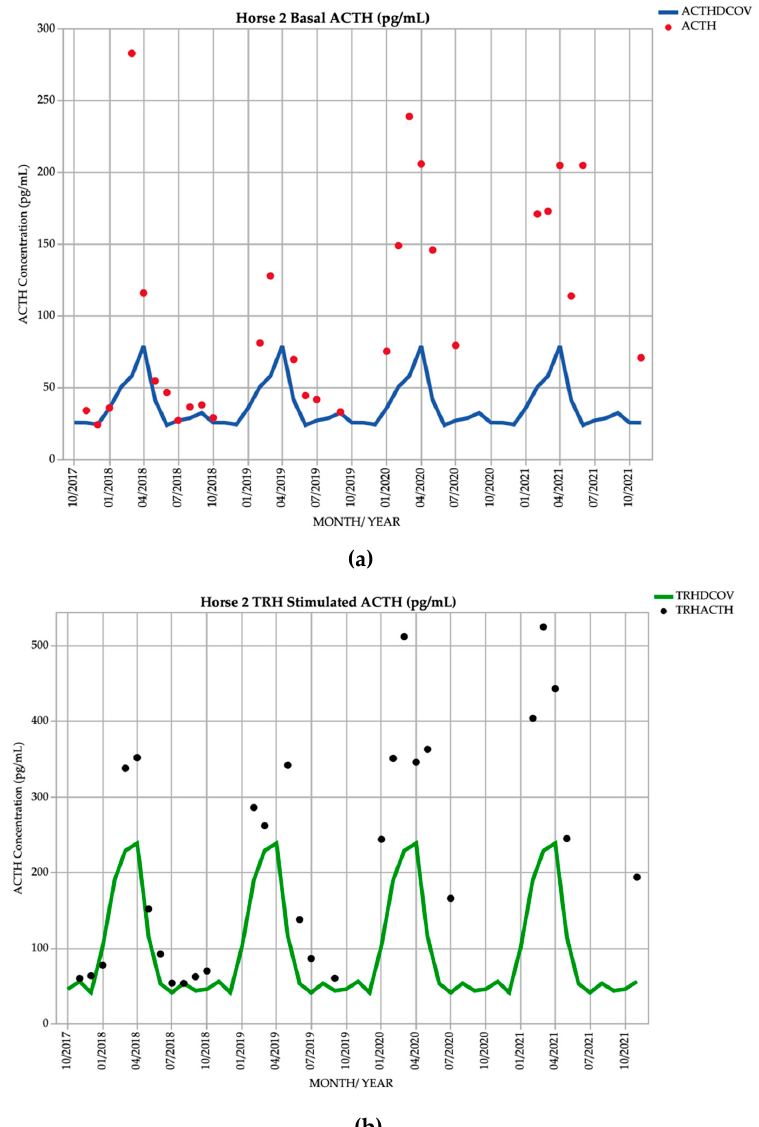
Figure 2. Monthly ACTH concentration (pg/mL) in Horse 2 (21 ‐ year ‐ old Warmblood mare), com ‐ pared to locally derived, seasonally adjusted DCOV [2]. (a) Basal ACTH concentrations (red points) and basal ACTH DCOV (blue line) (b) TRH ‐ stimulated ACTH concentrations (black points) and TRH ‐ stimulated ACTH DCOV (green line).